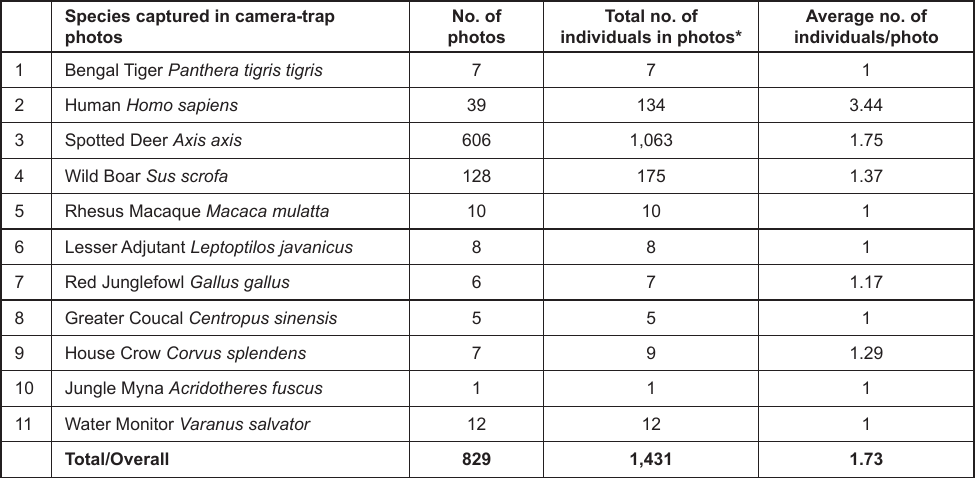
Table 2. Species captured in camera-trap photos in the Sundarbans East Wildlife Sanctuary. Species captured in camera-trap photos